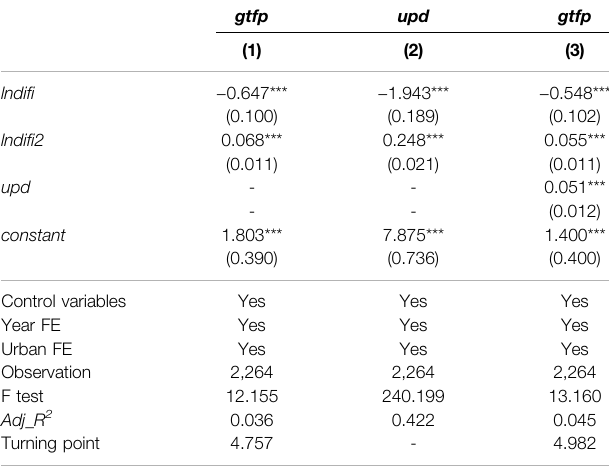
TABLE 12 | Analysis of industrial structure upgrading effect of the